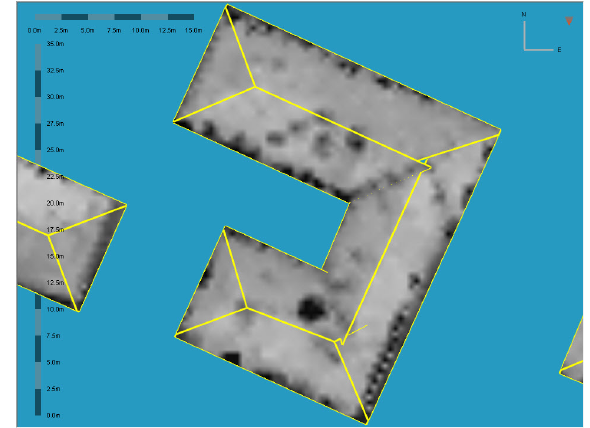
Figure 5: Roof’s polygons automatically